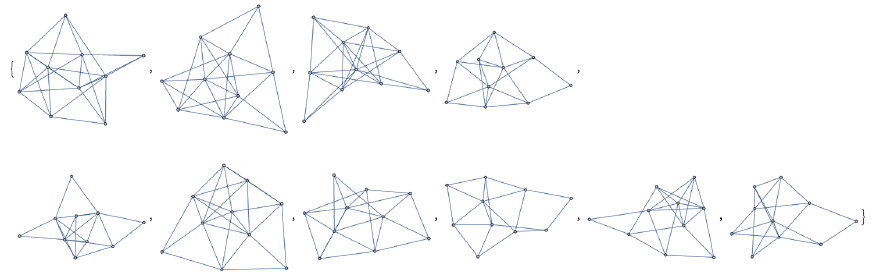
Figure 10. Graph representation of Q [2]